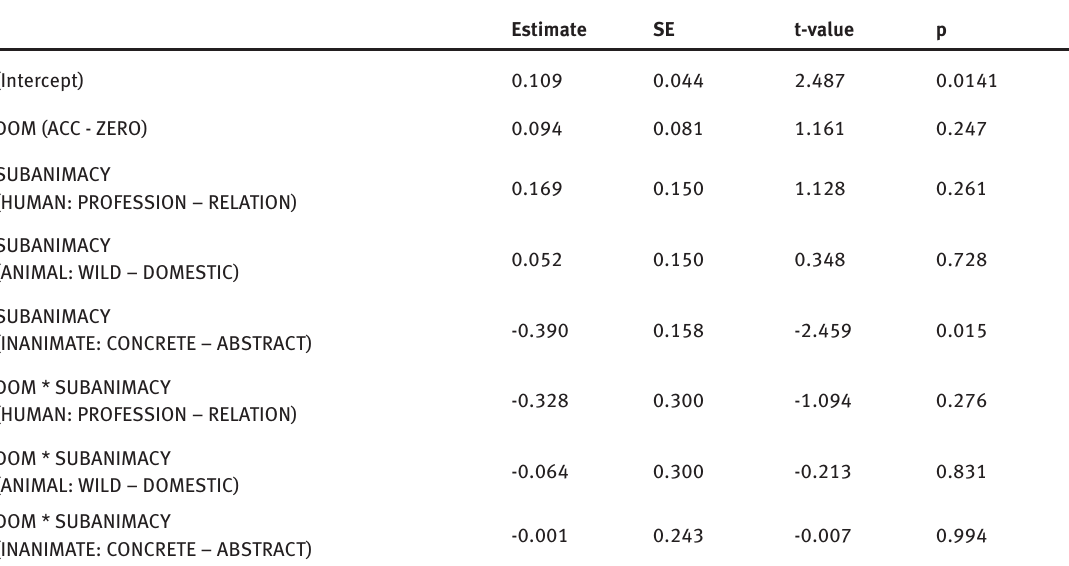
Table 3. lme results for the interaction of DOM and sub-animacy levels